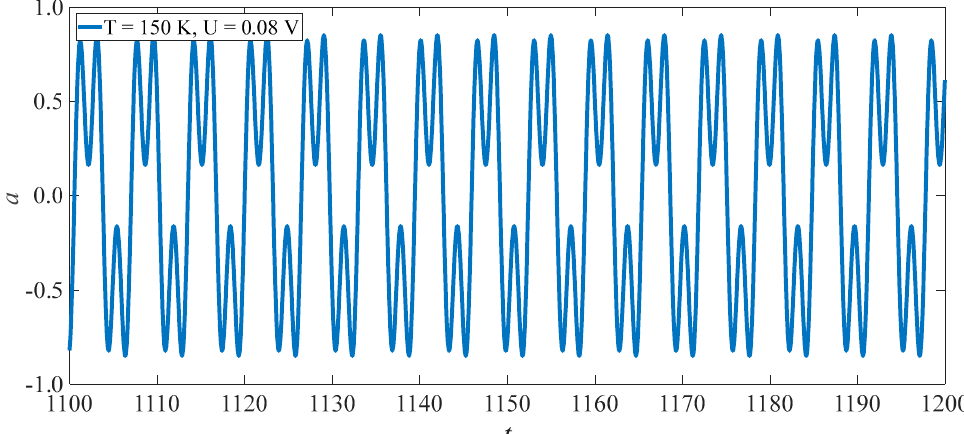
( ) ( ) ( ) ( ) ( c ) = ( 5,3.5,80 ) σ = 0 σ = 0 1 , f 1 , σ , , 5,3.5,8 c f . Figure 15. Numerical solution of first mode with , , 5,3.5,8 c f . 1 1 1 1 ( ) ( ) σ = 0 , , 5,3.5,8 c f . 1 1